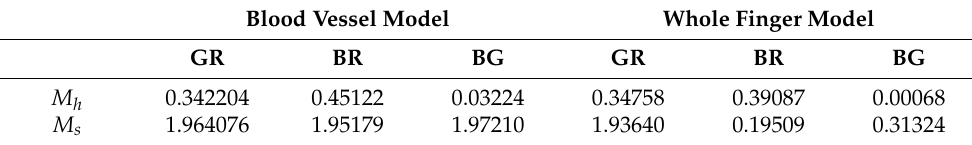
Table A1. M h and M s statistics. Blood Vessel